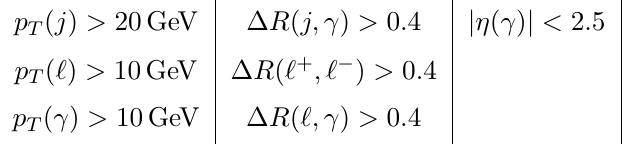
Table 1 . Parton level cuts used in the generation of events for all the background samples, when they are